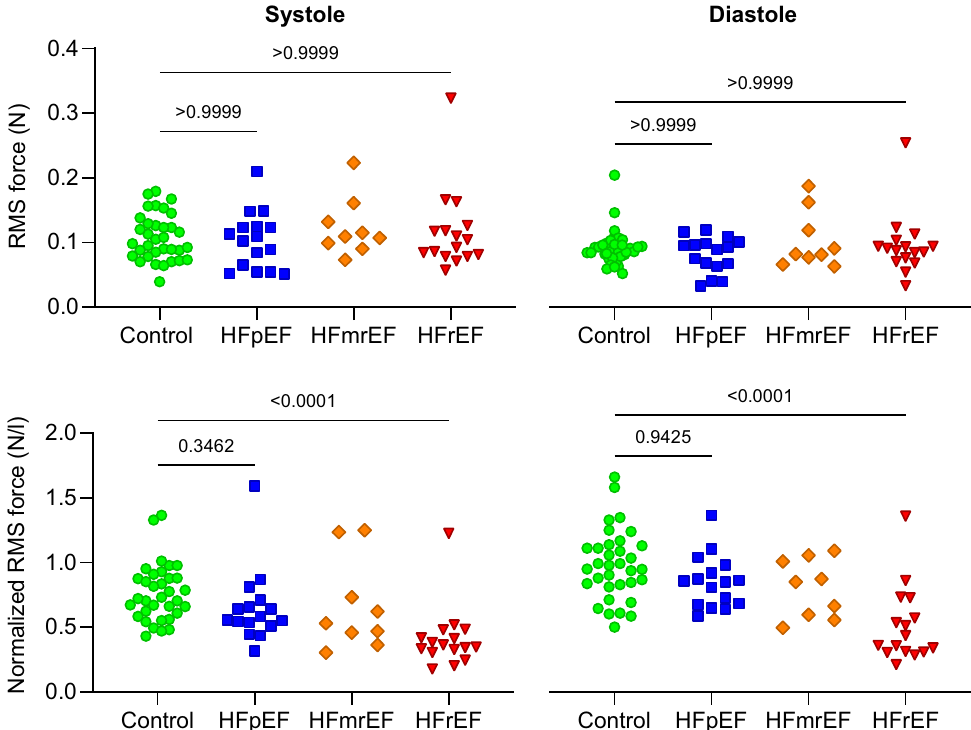
Figure 4. Group comparison of F RMS in systole (left column) and diastole (right), with and without LV volume normalization. Importantly, no significant differences were seen between healthy controls and HFpEF patients.